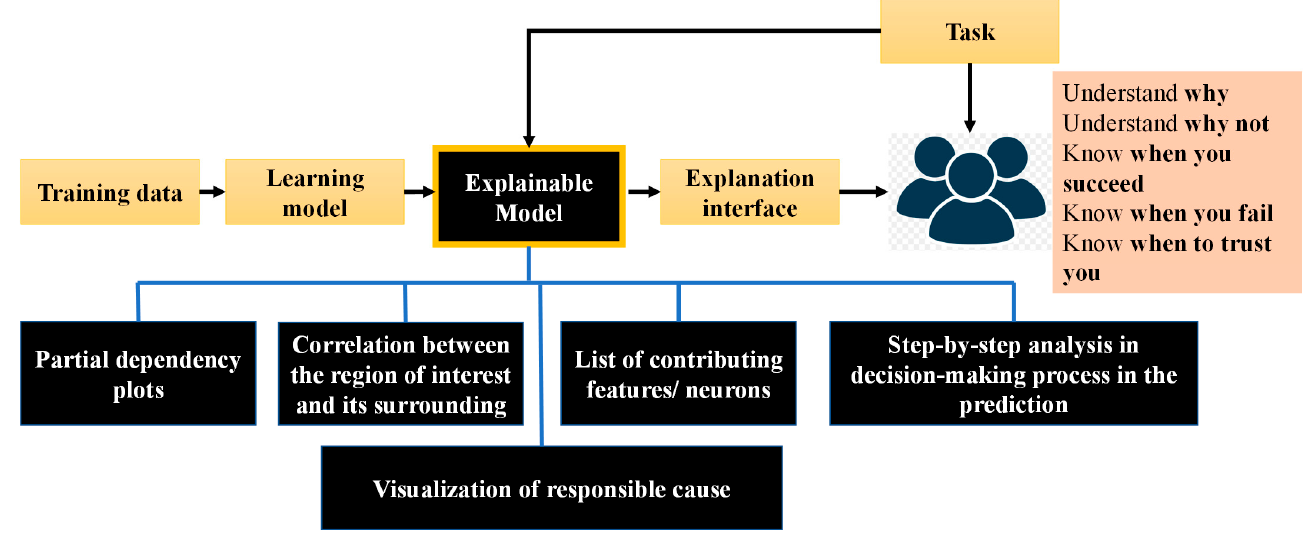
Figure 10. The schematic diagram of XAI for a machine learning-based model to achieve a transparent and trustworthy model.